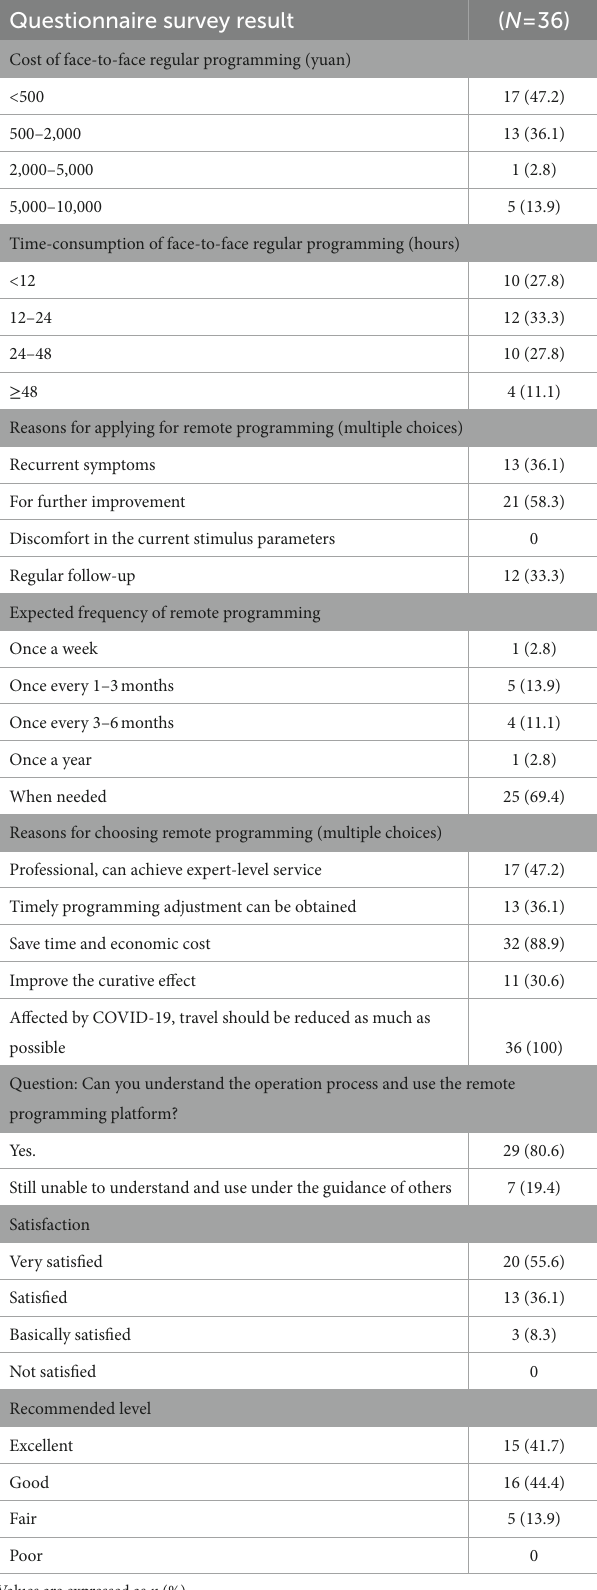
TABLE 2 Questionnaire